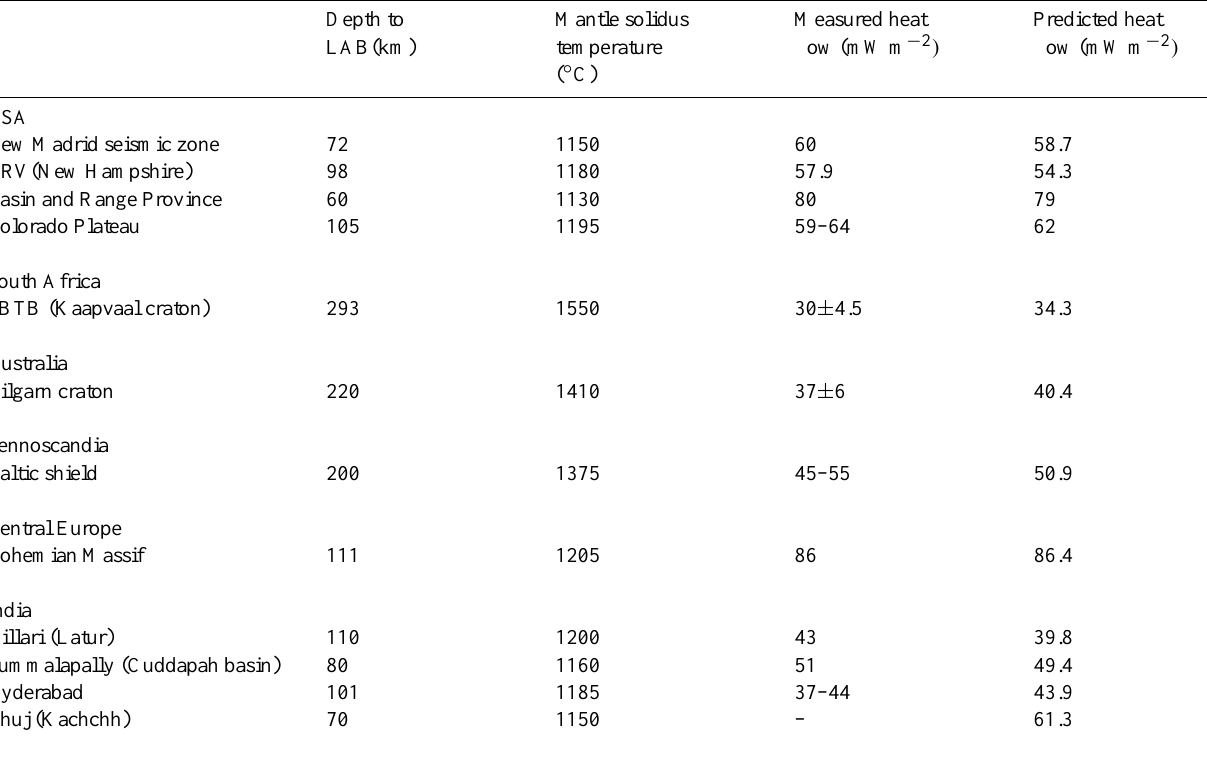
Table 3. Measured and predicted heat flow for different geotectonic locations. Data source is given in the